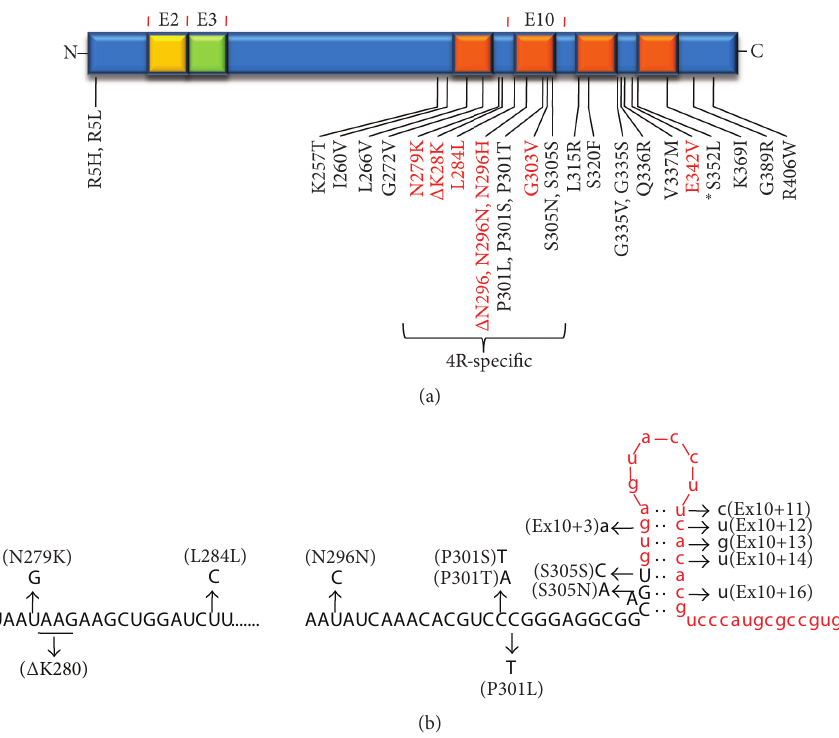
F 4: Mutations in tau associated with dominant familial frontotemporal dementia. (a) Almost all mutations in the coding region are found in the �-terminal region, in and around the microtubule binding domains. Some of these are speci�c to the 4R isoforms, as they are encoded in exon 10. Mutations in red lead to increased 4R tau relative to 3R tau. e asterisk near S352L denotes a single example of a lethal recessive tau mutation, which presented as respiratory hypoventilation and displayed neuronal tau pathology [85]. (b) Other mutations are found in the intron following exon 10, and these disrupt a hairpin structure in the pre-mRNA that regulates exon 10